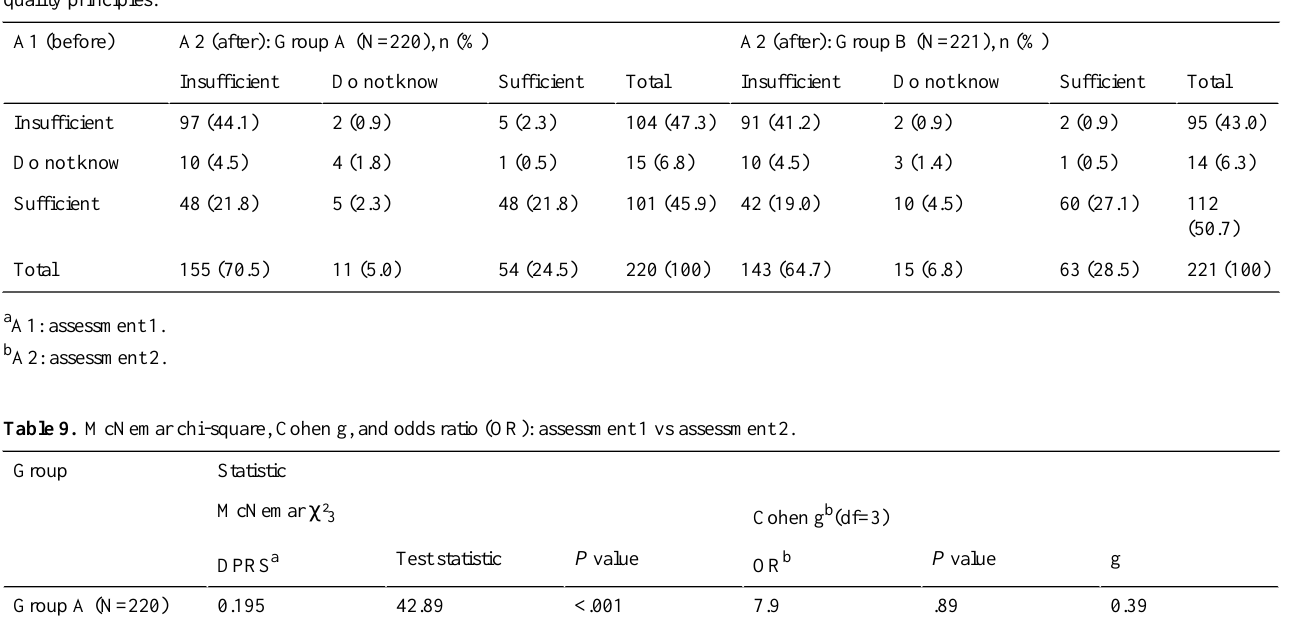
Table 8. Presentation of the contingency table (A1 a vs A2 b ) before and after the clarification of quality principles and the targeted search for these quality principles.